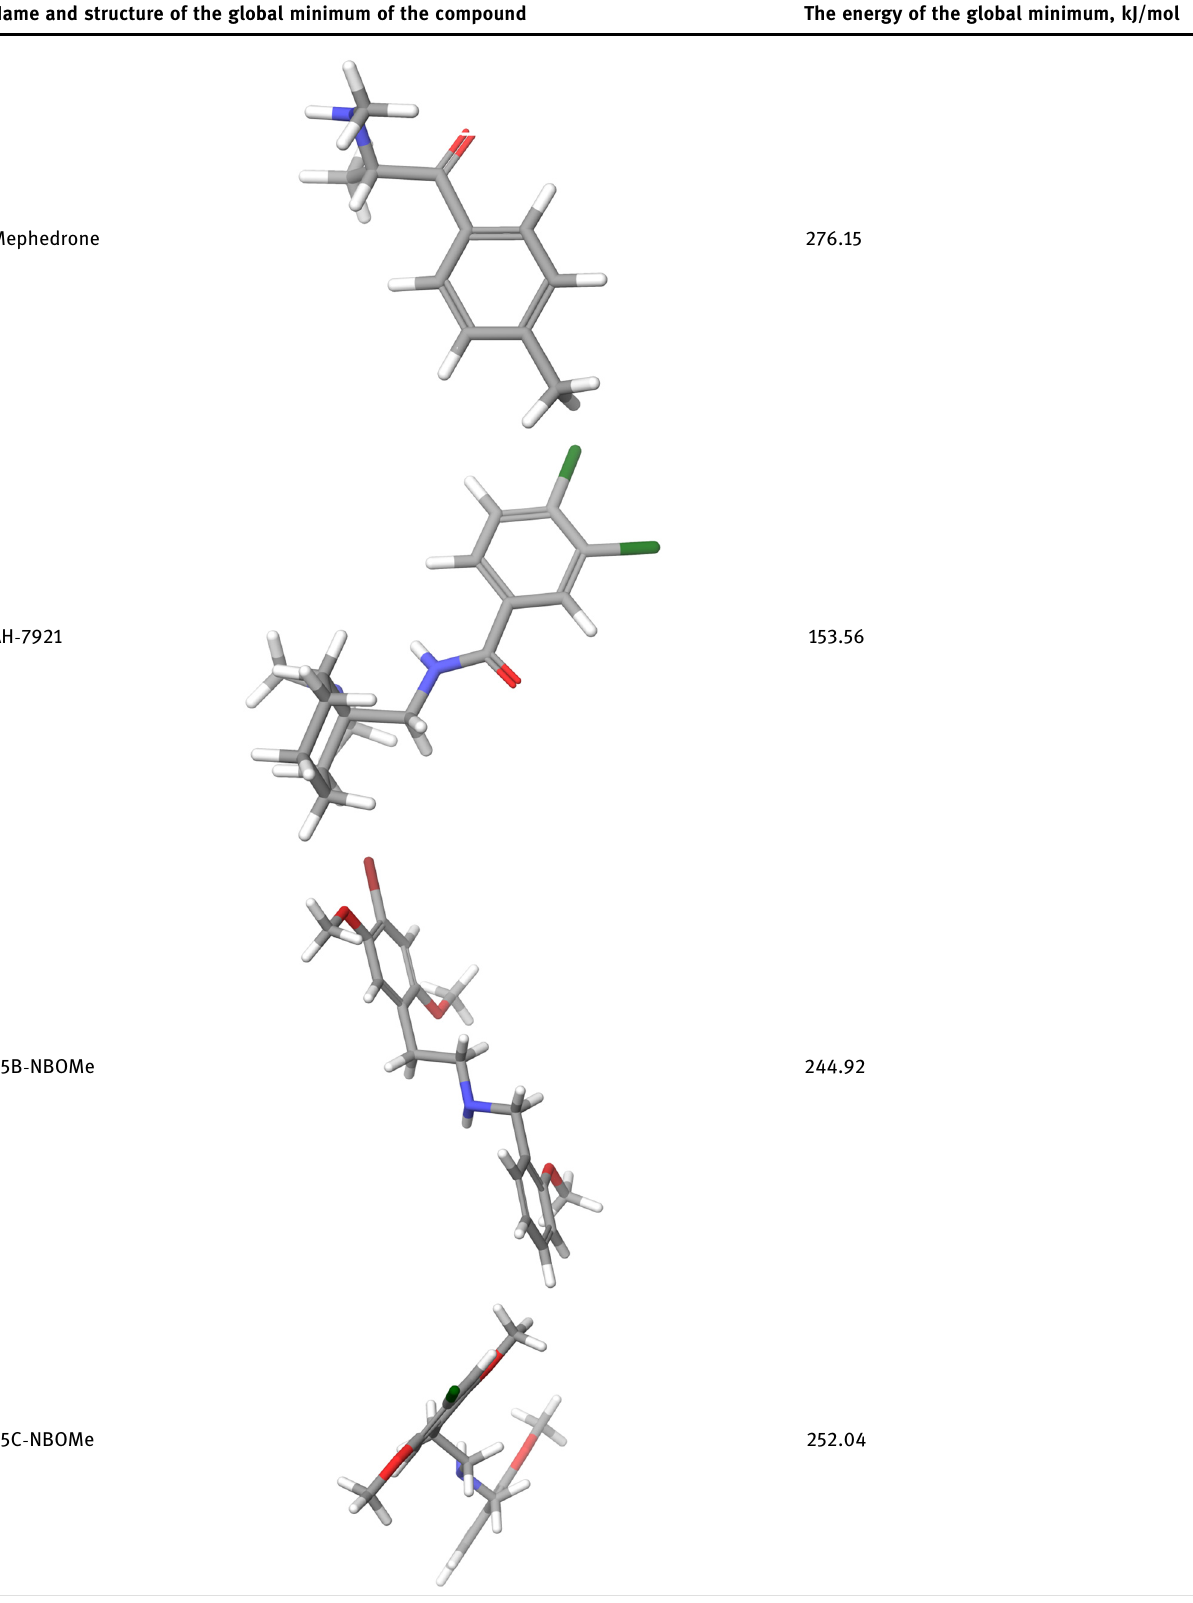
Table 6: Structures of the global minima and their energies Name and structure of the global minimum of the